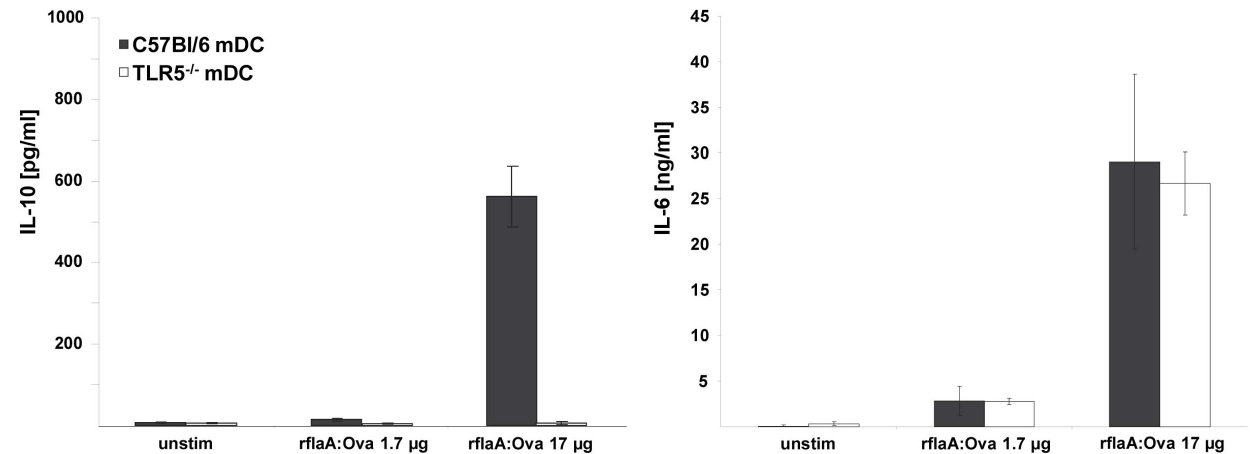
Figure 6. flaA:Ova induced IL-10 secretion from mDC is abrogated in TLR5 deficient mice. C57BL/6 and TLR5 2 / 2 mDC were stimulated with rflaA:Ova. Levels of IL-6 and IL-10 were analyzed by ELISA after 72 h. Results are means 6 SD of two independent experiments.